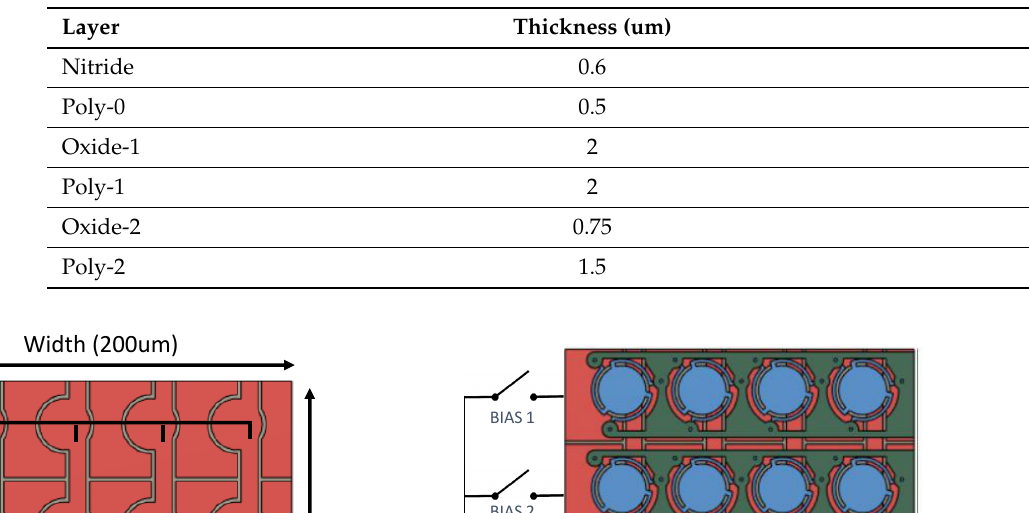
Table 2. PolyMUMPs Layers.